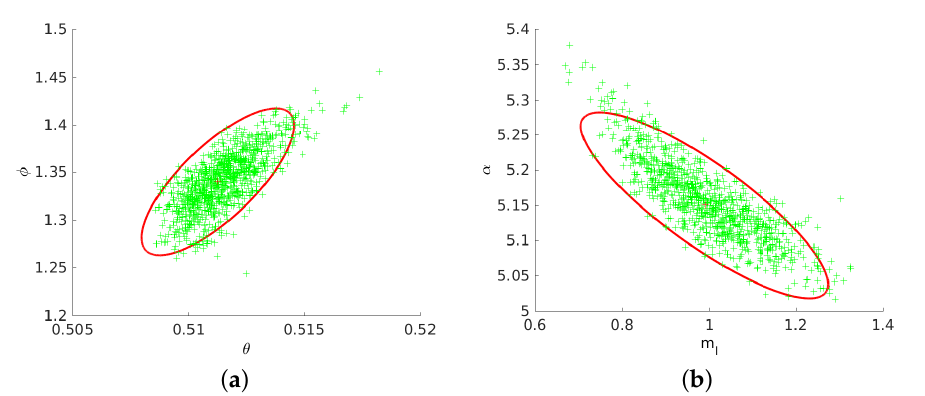
Figure 7. Monte Carlo test to validate the uncertainty estimation of line triangulation. ( a ) The red ellipse denotes the estimated 95% confidence region of ( θ , φ ) . Red “+” denotes the ground truth. Each green “+” represents a noisy estimation of ( θ , φ ) . ( b ) The red ellipse denotes the estimated 95% confidence region of ( m l , α ) . Red “+” denotes the ground truth. Each green “+” represents a noisy estimation of ( m l , α )